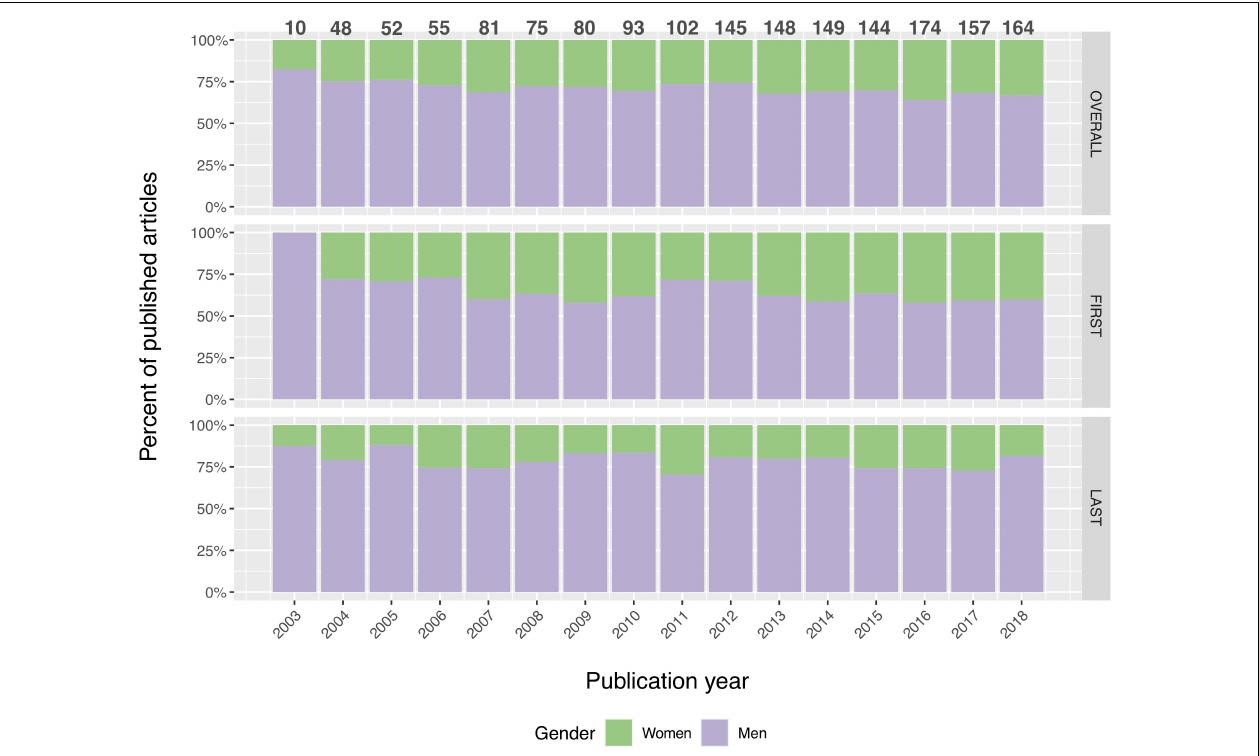
FIGURE 5 | Change in overall individual contribution of genders to published articles over time (top panel) disaggregated by first (middle panel) and last author (bottom panel) position for articles with more than one author. Numbers at the top of each bar indicate the total number of articles published that year.